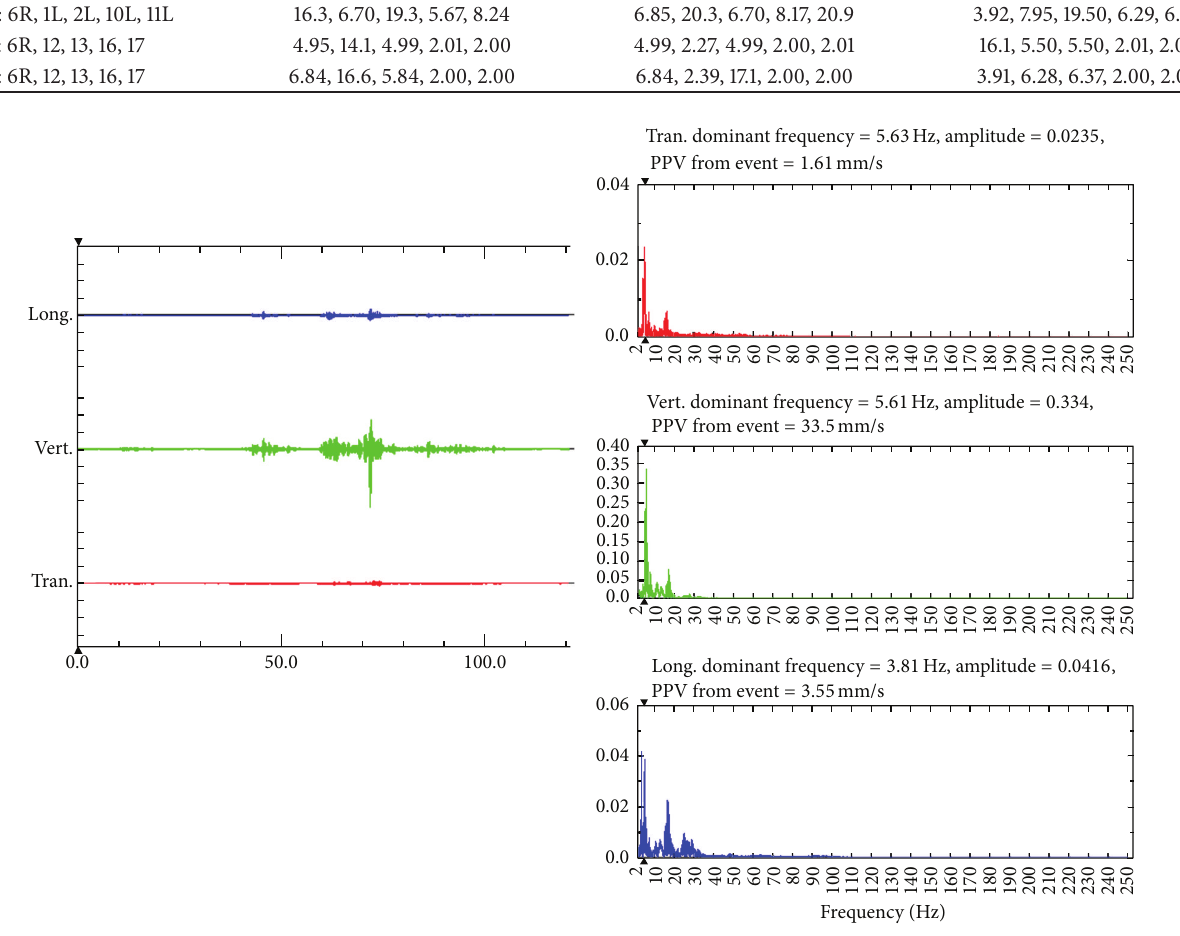
Figure 9: Measurement on moveable station 8R (middle of the span).